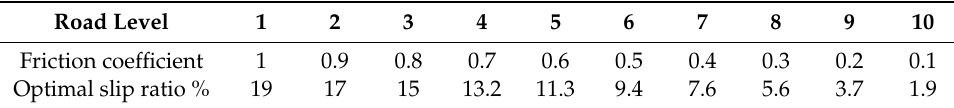
Table 1. Road friction coefficient and the corresponding optimal slip ratio. Road Level 1 2 3 Friction coefficient